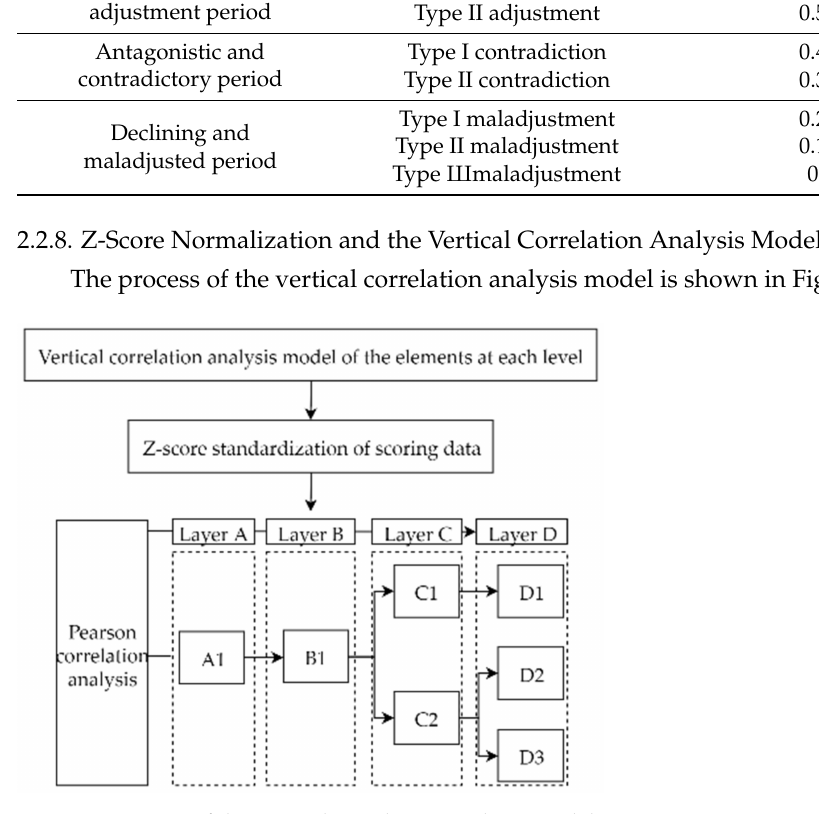
Figure 4. Process of the vertical correlation analysis